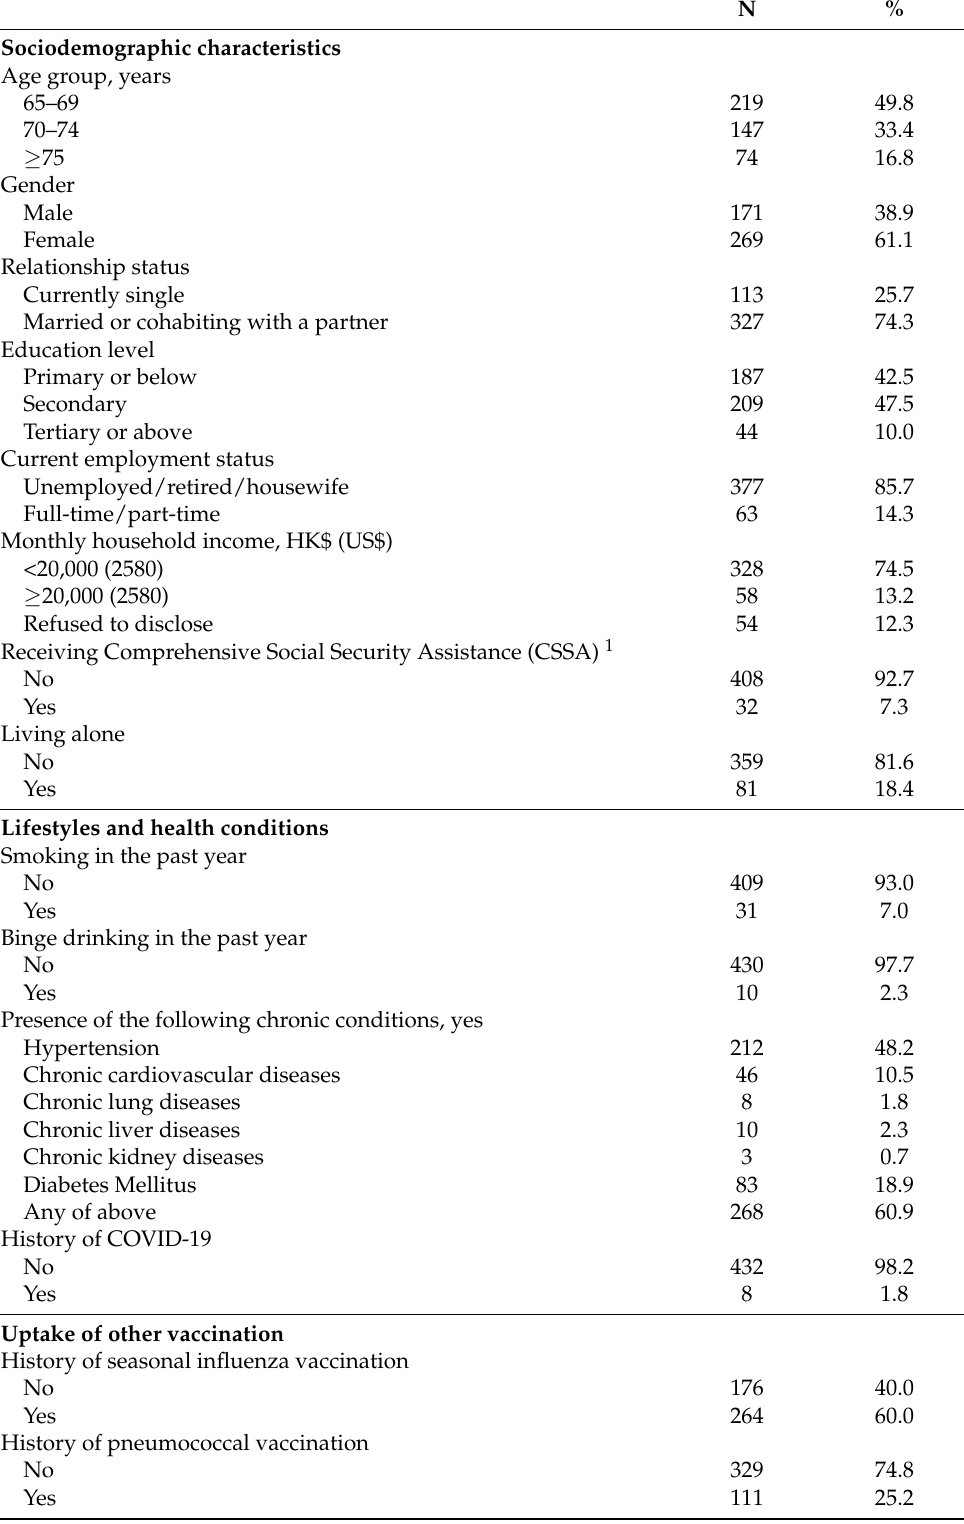
Table 1. Background characteristics of the participants (n =